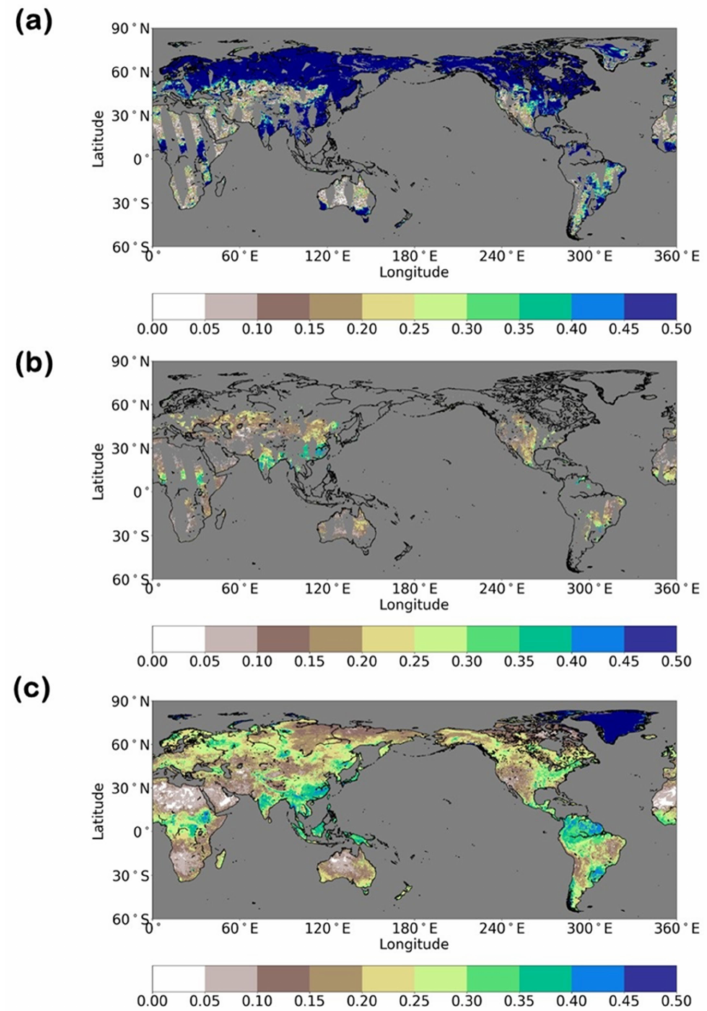
Figure 1. ( a ) Soil wetness on 1 July 2019 from ASCAT, ( b ) surface volumetric soil moisture after thinning and scaling the ASCAT soil wetness, and ( c ) the first soil layer volumetric soil moisture from LSM at an instant time of 00Z 1 July